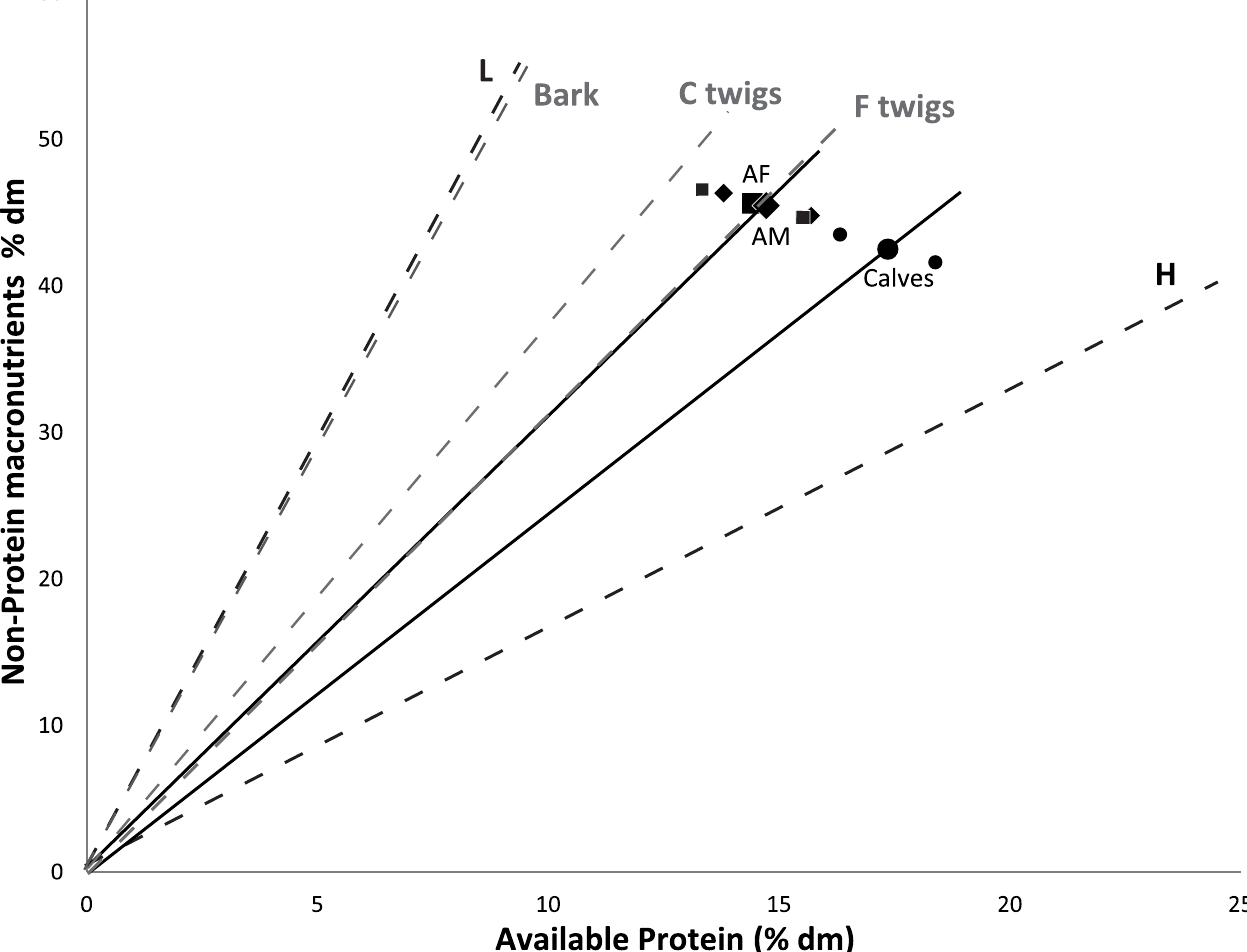
Fig 3. The nutritional target of captive moose in relation to food pellets and browse items. Pellets provided the moose with 98% of their total intake. The average balance between available protein (% of total dm ingested) and non-protein macronutrients (% of total dm ingested of TNC1+lipids+dNDF, see text for definitions) in the pelleted food ingested per 24h period by adult females (AF), adult males (AM) and calves during the first buffet week of the experiment indicate their preferred nutritional state (large solid square = mean for all AF, small solid squares = mean for each individual AF; large empty diamond = mean for all AM, small empty diamonds = mean for each individual AM; large solid dot = mean for all calves, small solid dots = mean for each individual calf). The mean trajectories of adults and calves are indicated with solid black lines. Dashed black food rails show the composition of the low- protein pellets (L) and high-protein pellets (H). Had individuals chosen to eat only one of L or H, their resulting point would have fallen somewhere along one of these two lines (Fig 1). Dashed grey food rails show the average composition of coarse twigs (C twig), fine twigs (F twig) and bark from three Salix species (Table